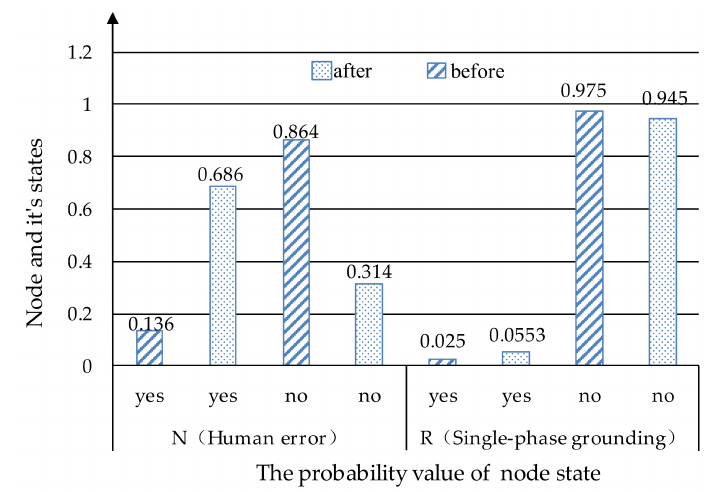
Figure 8. Case study for theft and incorrect operation.